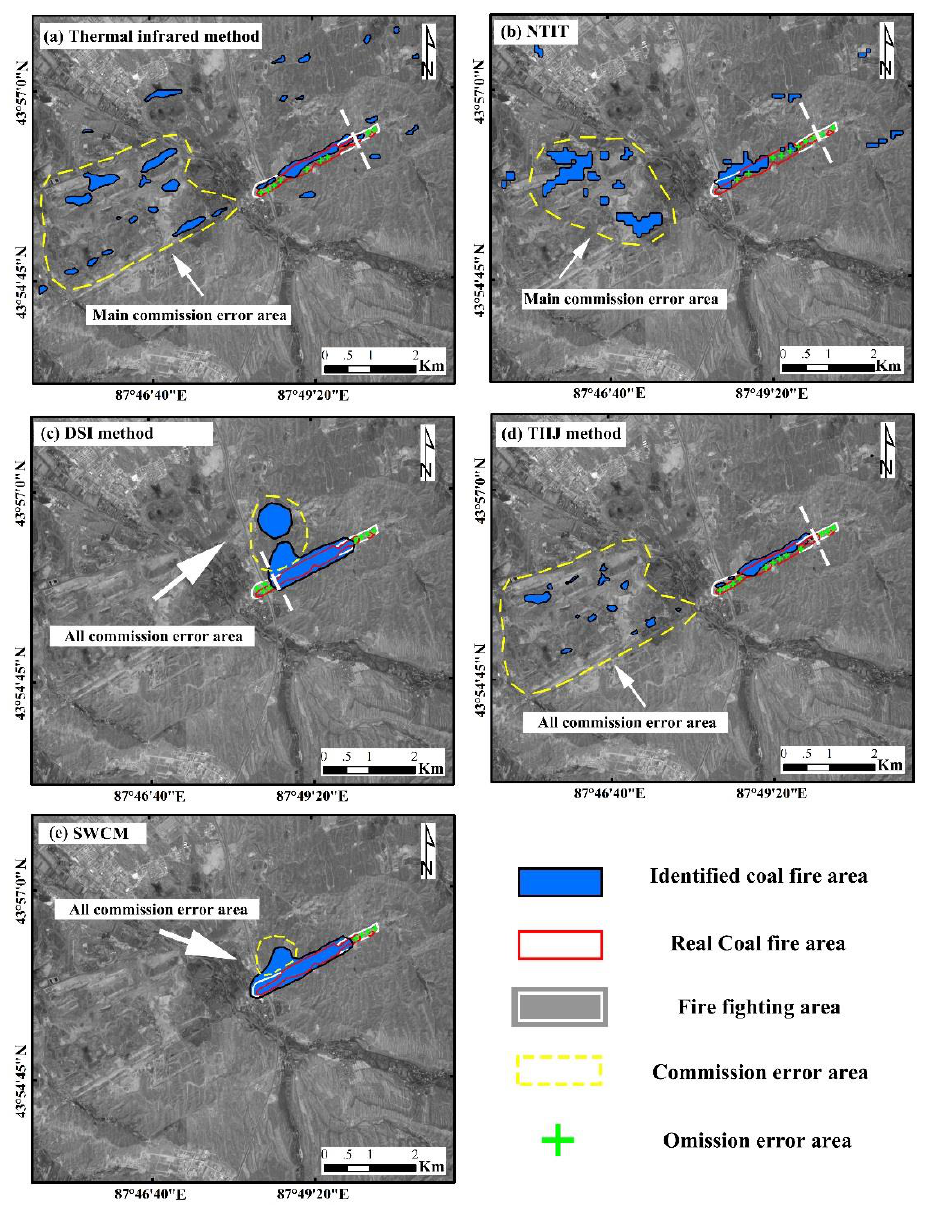
Figure 10. Comparison of the real coal fire areas and coal fire areas identified by different methods: ( a ) thermal infrared method; ( b ) nighttime thermal infrared technology (NTIT); ( c ) DSI method; ( d ) thermal infrared and InSAR (interferometric synthetic aperture radar) joint method (TIIJ); ( e ) the proposed SWCM.